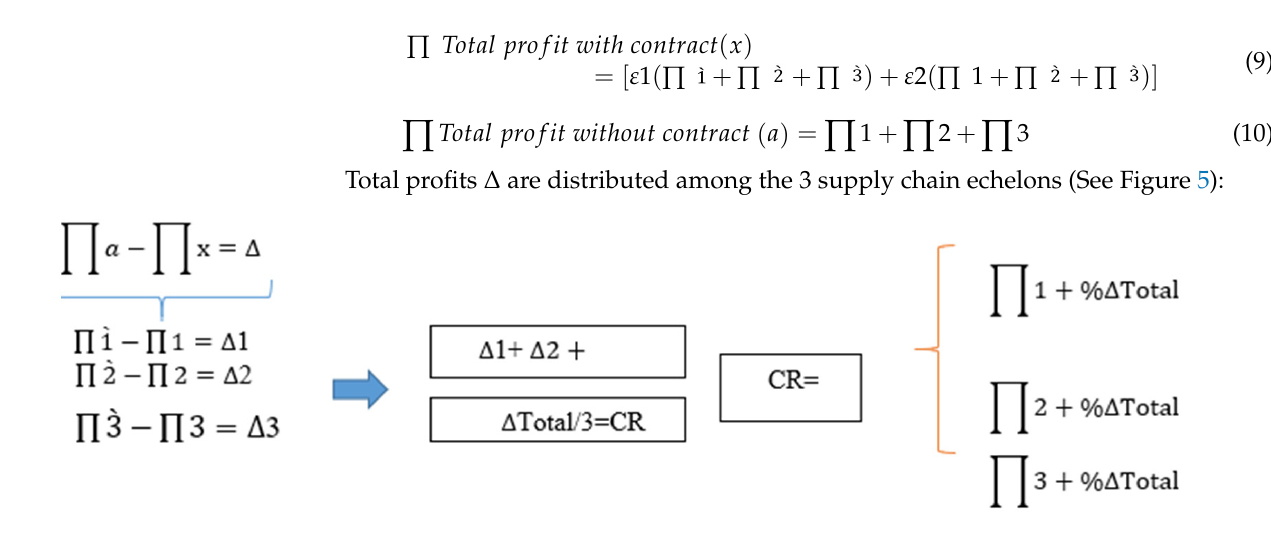
Figure 5. Distribution of total profits.